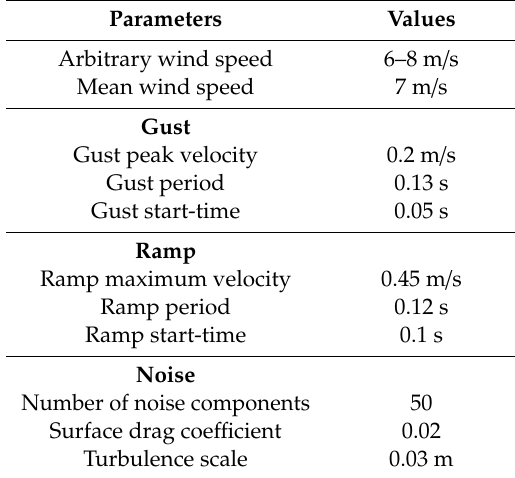
Table 8. Arbitrary wind speed data input for the wind source.